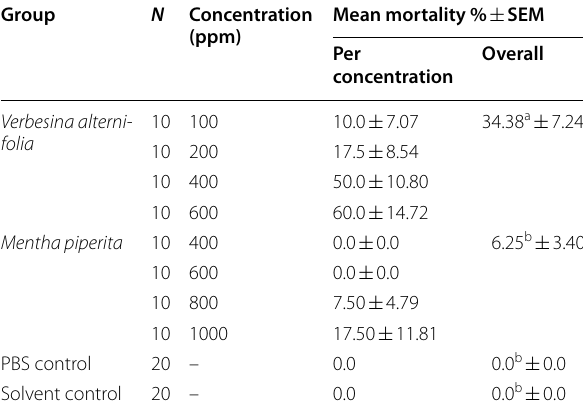
Different letters within the overall mortality column indicate significantly different means at p < 0.05 (Tukey HSD test)